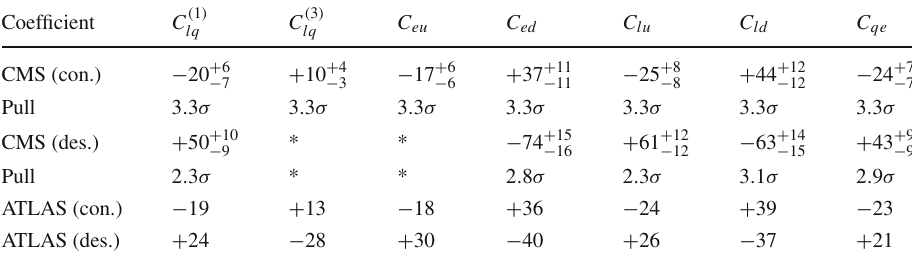
(cid:12) R SM μμ/ measured by the CMS collaboration in nine m (cid:2)(cid:2) bins between 200 and 3000 GeV are shown ee , ij